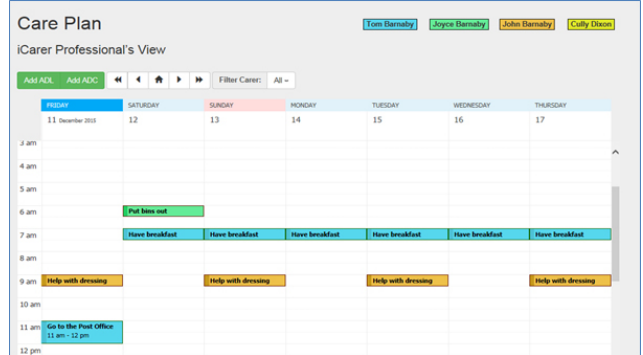
Figure 3. Activities and daily living(ADL) and activities of daily care (ADC).